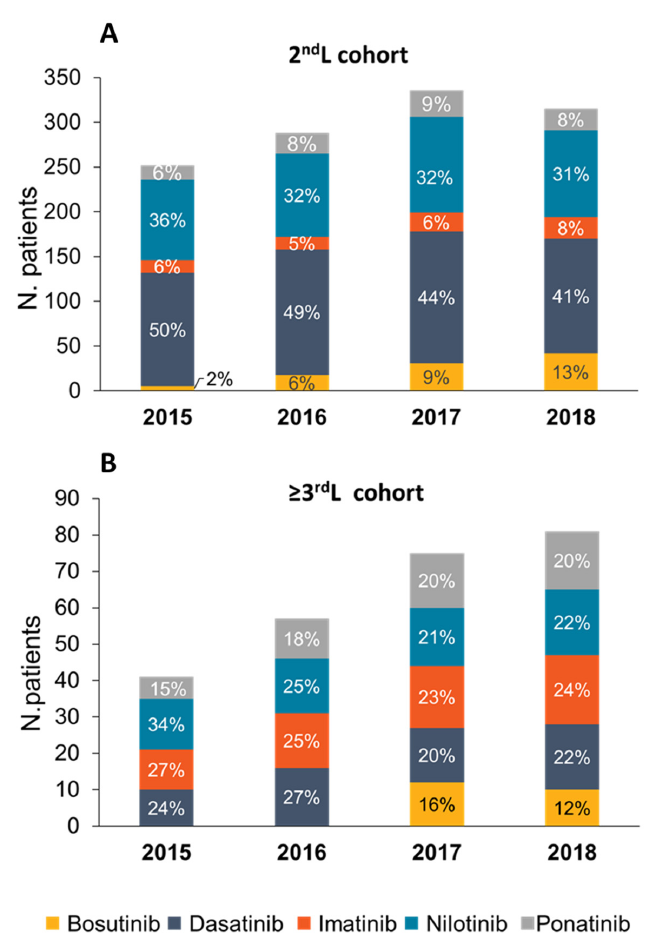
Figure 1. Distribution of patients by TKI in each calendar year in the 2nd L ( A ) and ≥ 3rd L ( B ). Table 3. Treatment patterns of patients in 2nd L ( a ) and ≥ 3rd L ( b ) cohorts, overall and stratified by TKI agent.